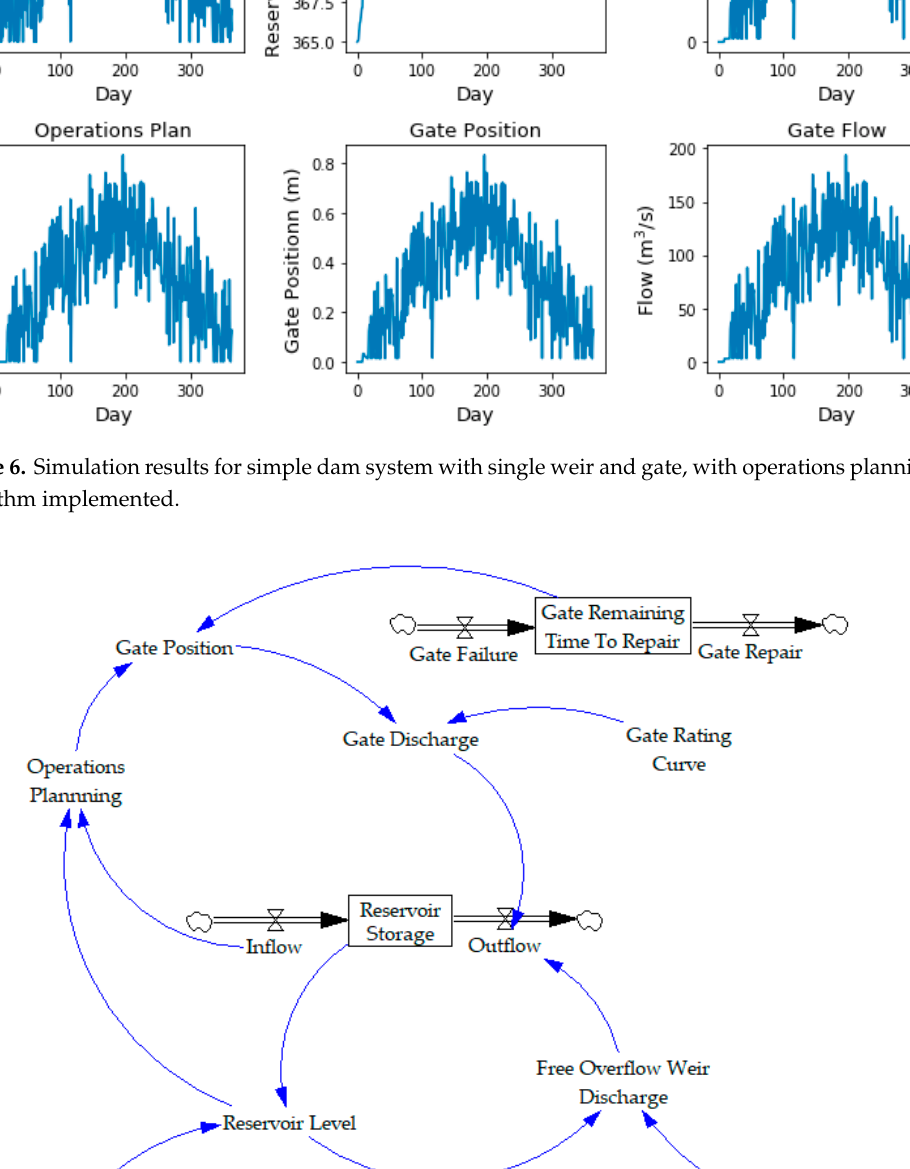
Figure 8. Simulation of simple system with single gate and weir, operations planning, and gate failure implemented.